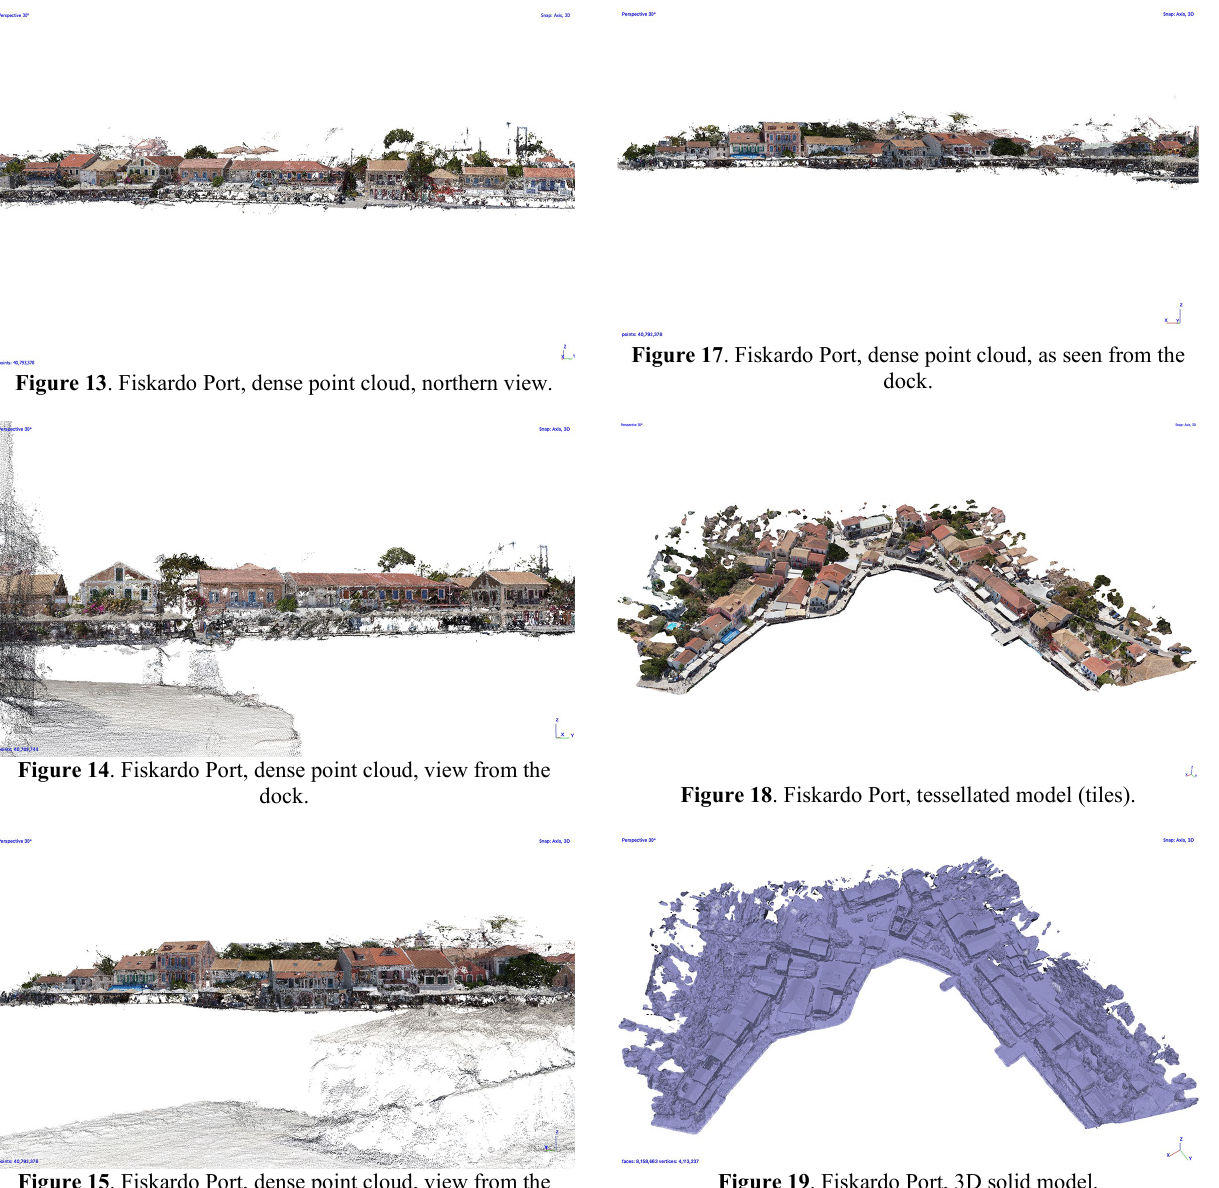
Figure 12 . Fiskardo Port, dense point cloud, southern view.